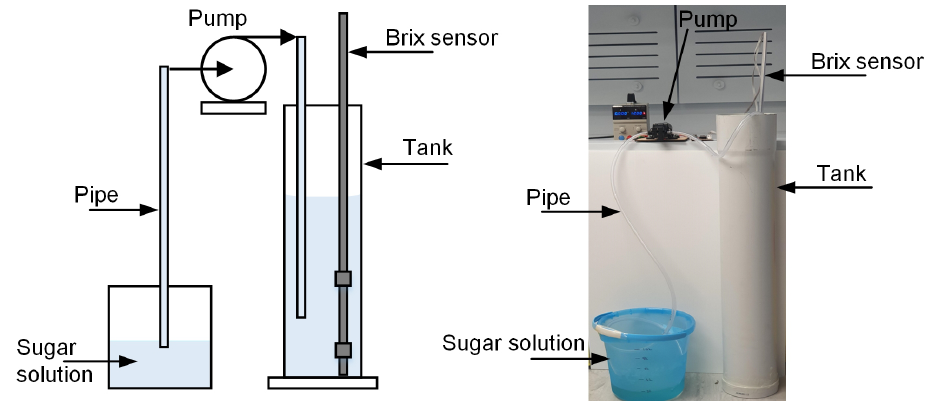
Figure 5. Experimental set up for sugar monitoring in the lab.